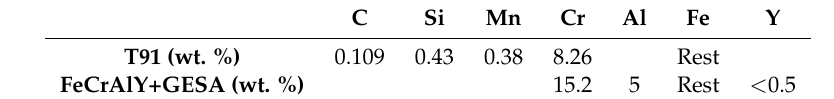
Table 1. Composition of the most abundant elements in the T91 steel substrate and FeCrAlY coating as measured in [1].